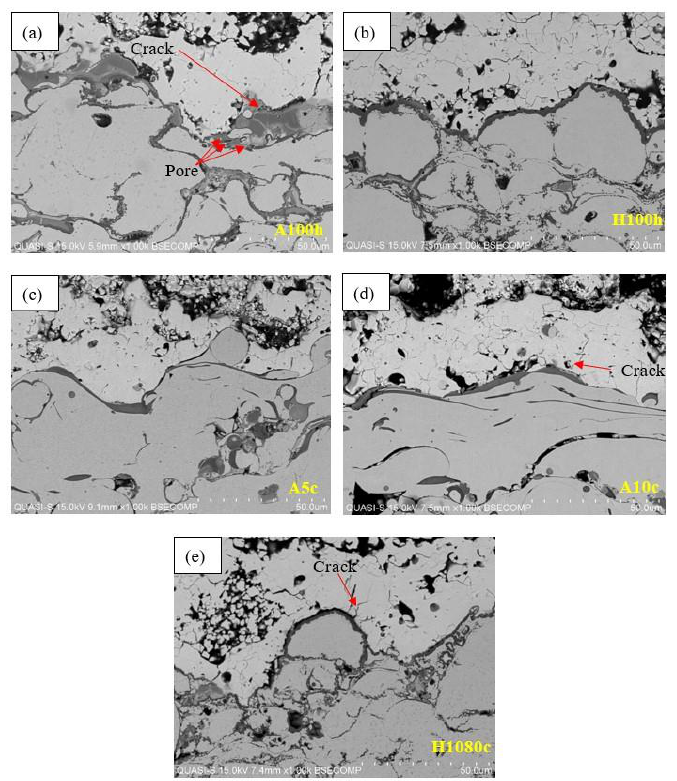
Figure 2. SEM micrographs of isothermal ( a ) A100h, and ( b ) H100h and thermal cyclic test ( c ) A5c, ( d ) A10c, and ( e ) H1080c. Coatings 2020 , 10 , x FOR PEER REVIEW